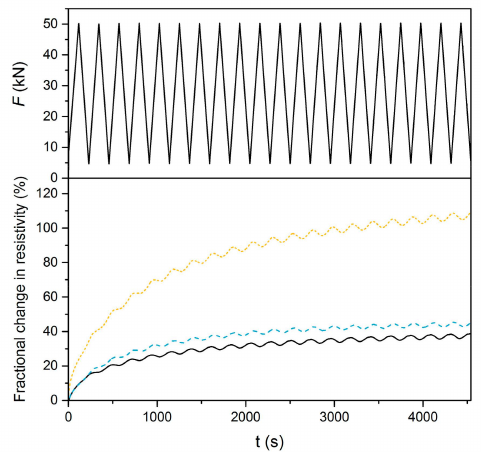
Figure 11. Compression sensitivity of composites G0, G3 and G10 under DC measurement.